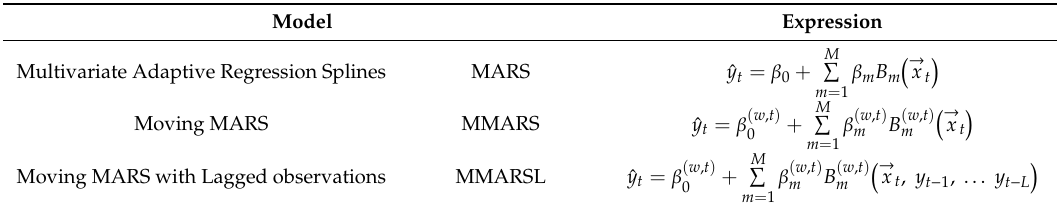
Table 3. Machine Learning